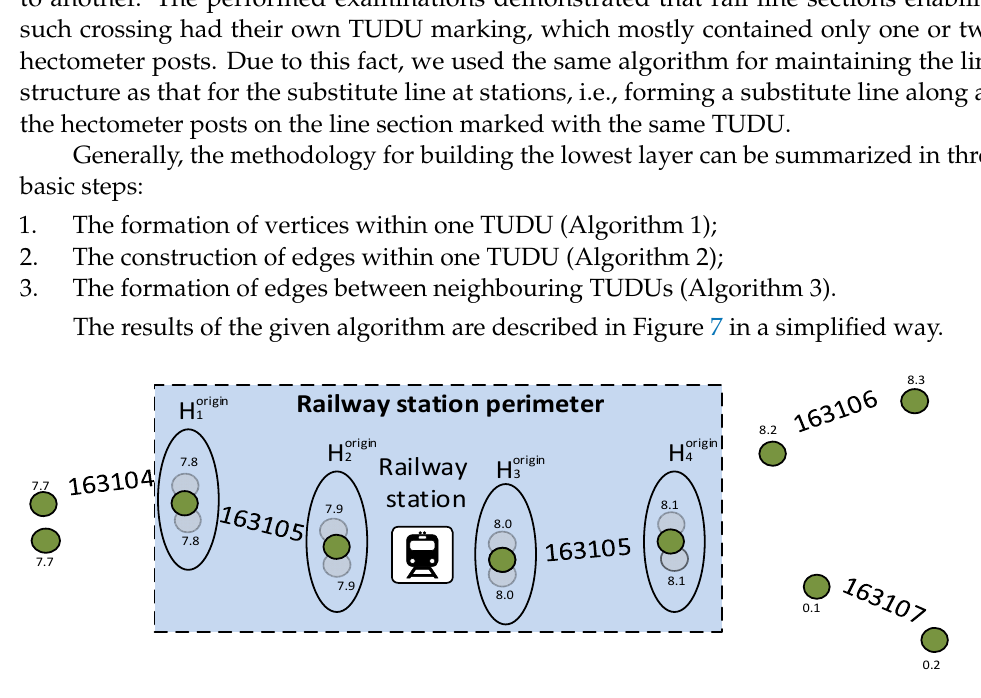
Figure 7. Illustration of algorithm used for the formation of vertices. Algorithm 2. Construction of edges within one TUDU.